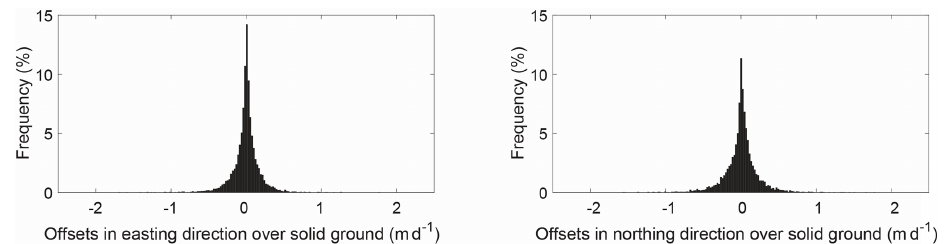
Figure 12. Distribution of velocity offsets in easting and northing direction over solid ground from SAR intensity tracking between 1 Oc- tober 2015 and 31 October 2016 (13 months). The mean easting offset is − 0 . 002md − 1 with a standard deviation of 0.173md − 1 , and the